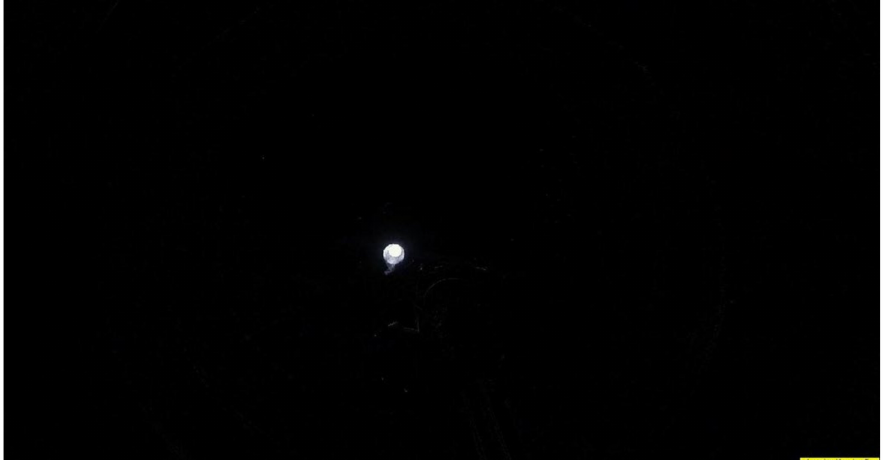
Figure 5. Image capture from Tracker showing movement of “smoke” into the interior of the structure after descending down the center opening following application of the “baseline subtract” function to the image in Figure 4. The outline of only the lighting stand is barely visible. The incoming “smoke” is clearly visible in the 6 o’clock